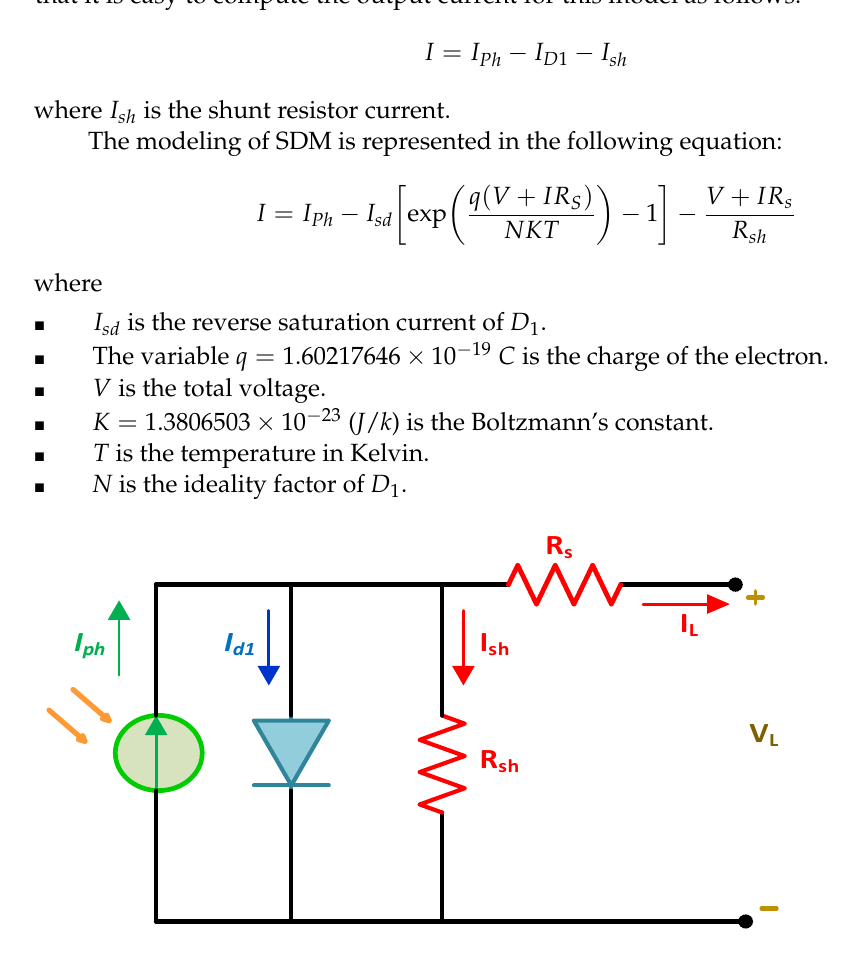
Figure 1. SDM mathematical model.